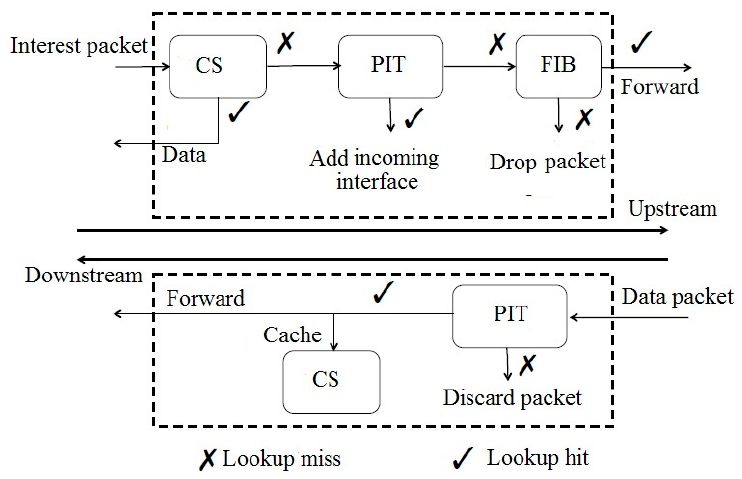
Figure2. Forwarding process at NDN router [8]. Figure 2. Forwarding process at NDN router